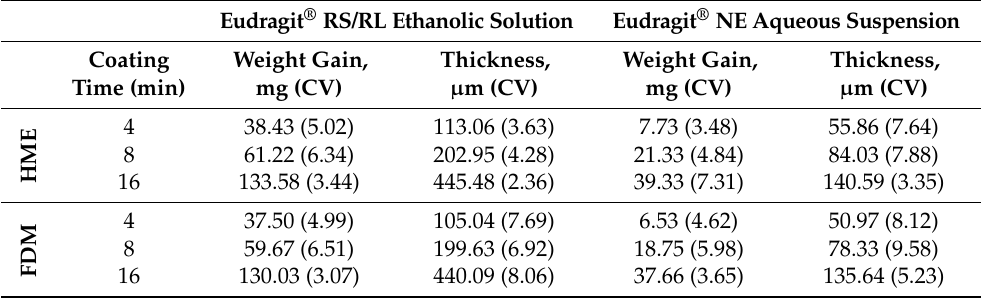
Table 3. Weight gain and coating thickness of extruded and printed samples coated for different